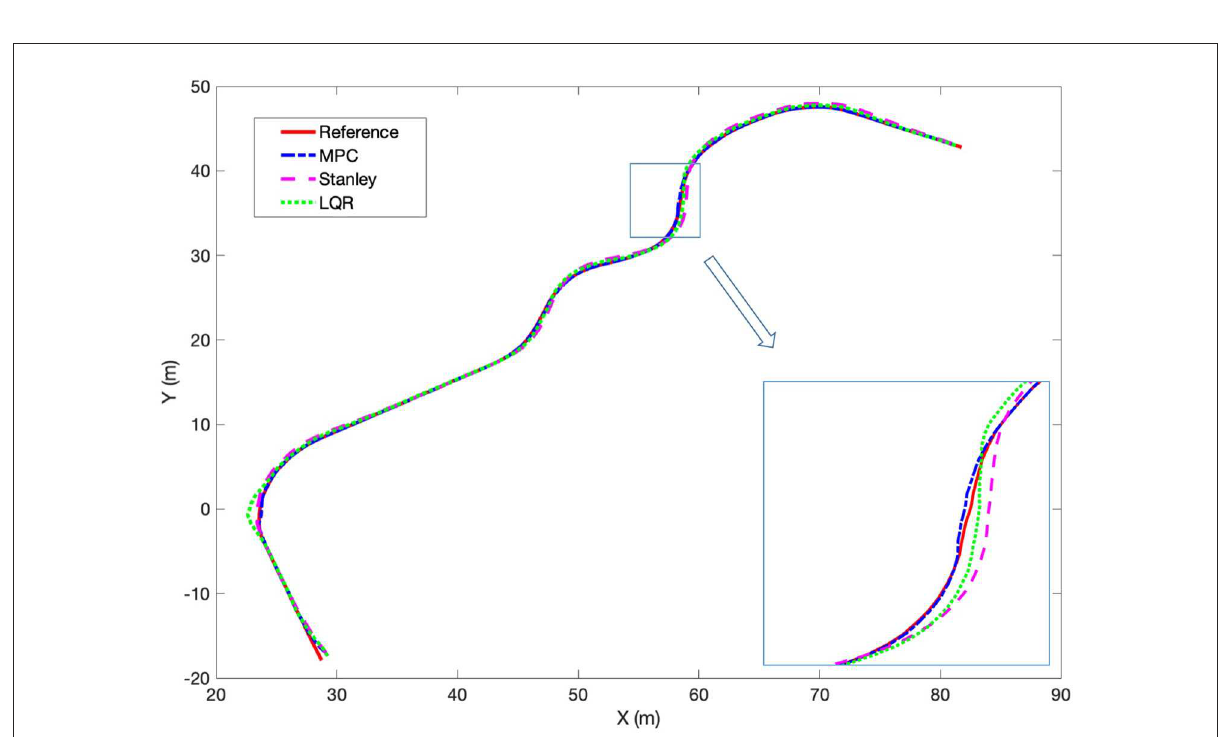
FIGURE15 The comparison of the tracking performance of MPC, Stanley, and LQR